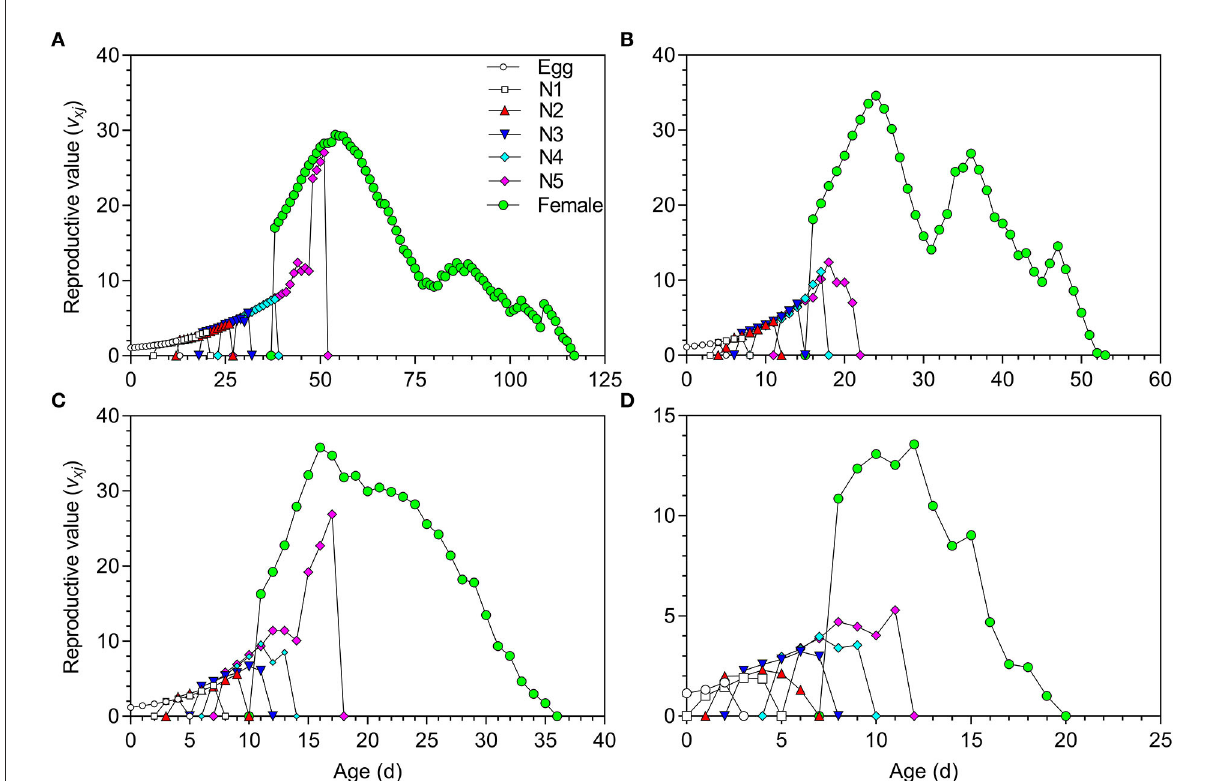
FIGURE4 Reproductive value ( v xj ) of Orius strigicollis fed on Frankliniella occidentalis at 18.5 ◦ C (A) , 23.5 ◦ C (B) , 27 ◦ C (C) , and 33 ◦ C (D) .